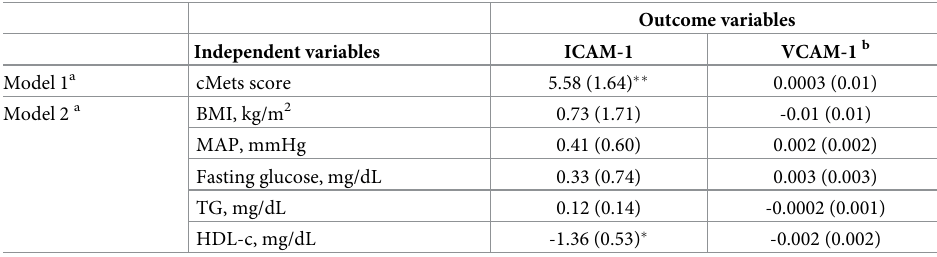
Table 4. Results of multiple regression analysis of the effect of metabolic syndrome score and its components on the levels of markers of endothelial dysfunction in